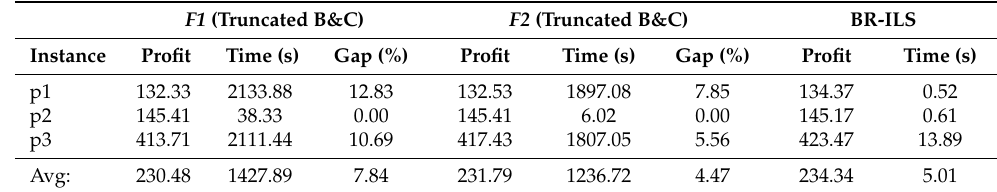
Table 5. Average results obtained for p 1, p 2, and p 3